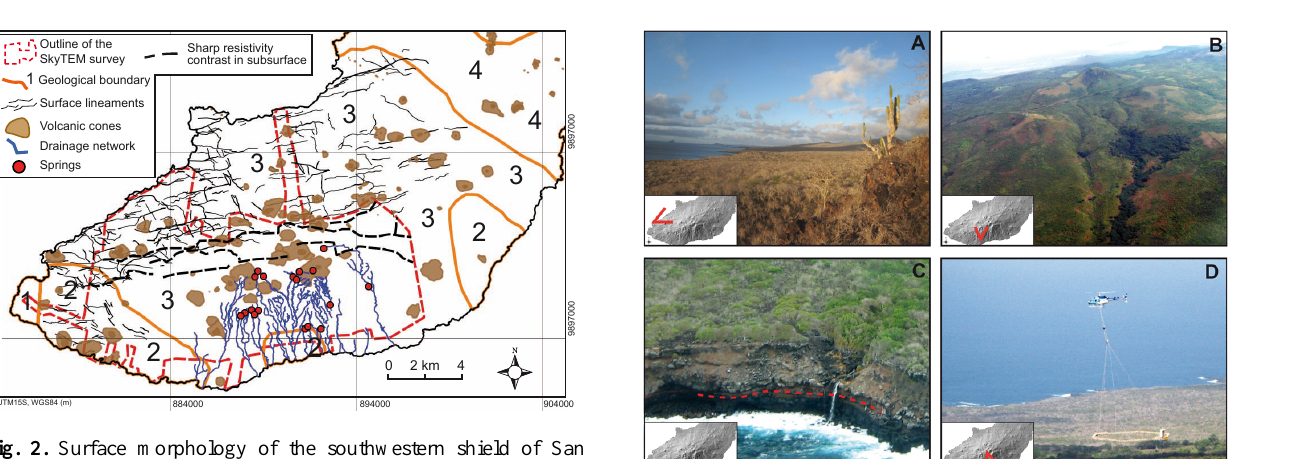
Fig. 2. Surface morphology of the southwestern shield of San Crist´obal island. Geological boundaries from Geist et al. (1986), see caption of Fig. 1 for details. Drainage network, surface lineaments and volcanic cones were mapped from the Google Earth® SPOT imagery and SRTM DEM. Black dashed lines underline major resistivity offsets in the 3-D geophysical model (Fig. 5).